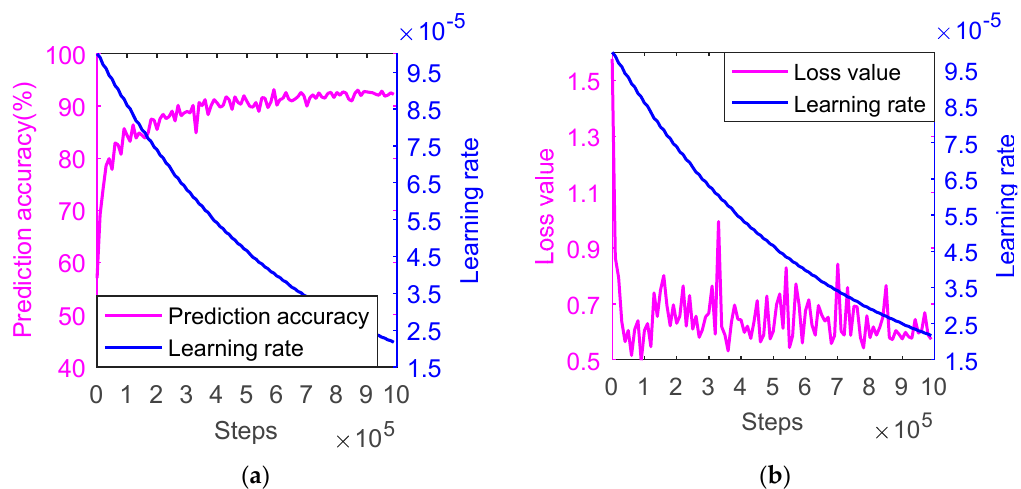
Figure 5. Setting of learning rate with exponential decay method using the training set. ( a ) The prediction accuracy v.s. the learning rate; ( b ) The loss value v.s. the learning rate.